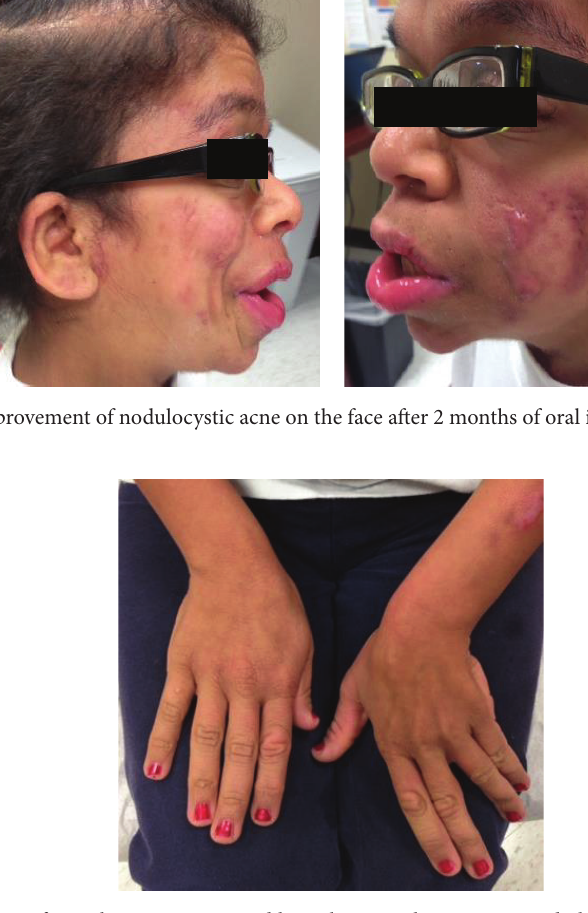
Figure 3: Significant improvement of acanthosis nigricans and hyperkeratotic hyperpigmented plaques on the hands after 2 months of oral